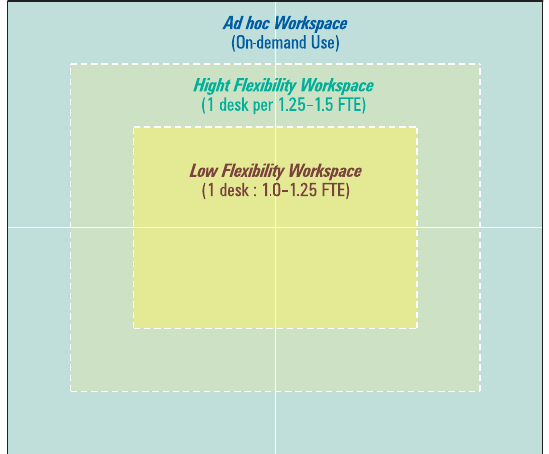
Flexible Working in Scottish Local Authority Property